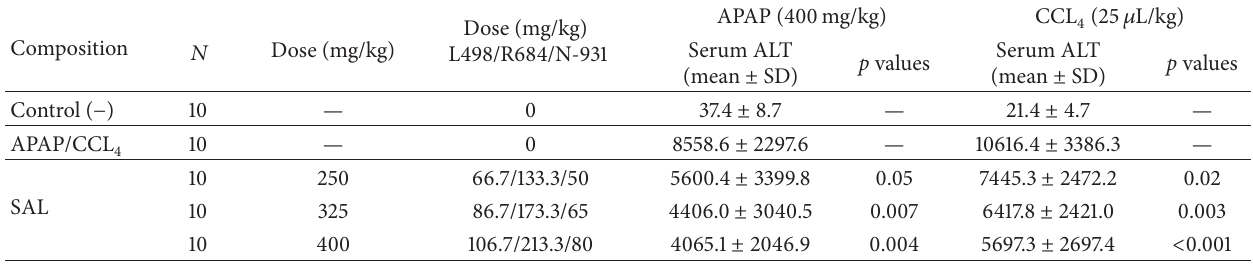
Table 1: Dose-correlated liver protection of the SAL composition in APAP/CCl 4 induced hepatotoxicity model.